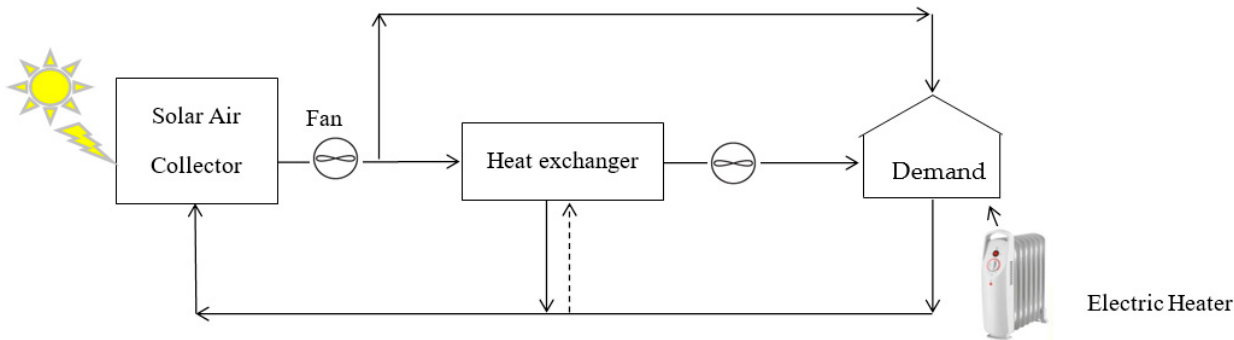
Figure 17. Schematic view of the automation system applied to different buildings [147].